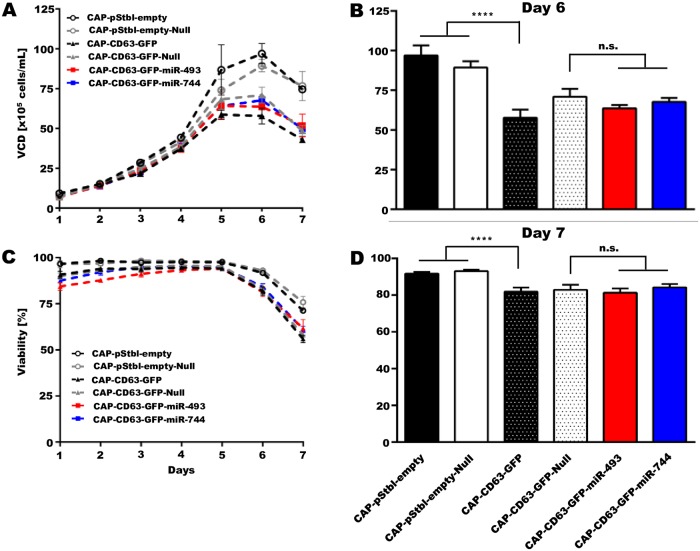
Impact of CD63-GFP and miRNA overexpression on CAP cell growth.(A) Viable cell density (VCD) of modified and of reference CAP cell lines during a 7 day cultivation, measured by trypan blue exclusion. (B) Viable cell density of modified and of reference CAP cell lines at day 6, measured via trypan blue exclusion. Significance was determined by using One-way ANOVA multiple comparison with Bonferroni correction [Each cell line cultured in 2 separate flasks; mean ± SD; n.s. = not significant, ****<0.0001]. (C) Viability of modified and of reference CAP cell lines during a 7 day cultivation, measured by trypan blue exclusion. (D) Viability of modified and of reference CAP cell llines at day 7, measured by trypan blue exclusion. Significance was determined by using One-way ANOVA multiple comparison with Bonferroni correction [Each cell line cultured in 2 separate flasks; mean ± SD; n.s. = not significant, ****<0.0001].